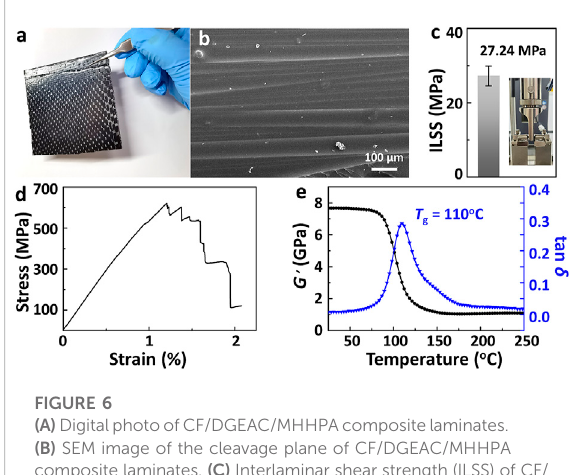
FIGURE 6 (A) DigitalphotoofCF/DGEAC/MHHPAcompositelaminates. (B) SEM image of the cleavage plane of CF/DGEAC/MHHPA composite laminates. (C) Interlaminar shear strength (ILSS) of CF/ DGEAC/MHHPA. Inset photo is the sample during ILSS test. (D) Stress – strain curve of CF/DGEAC/MHHPA composites under fl exural tests. (E) Storage modulus ( G ′ , black line) and tan δ (blue line) of CF/DGEAC/MHHPA